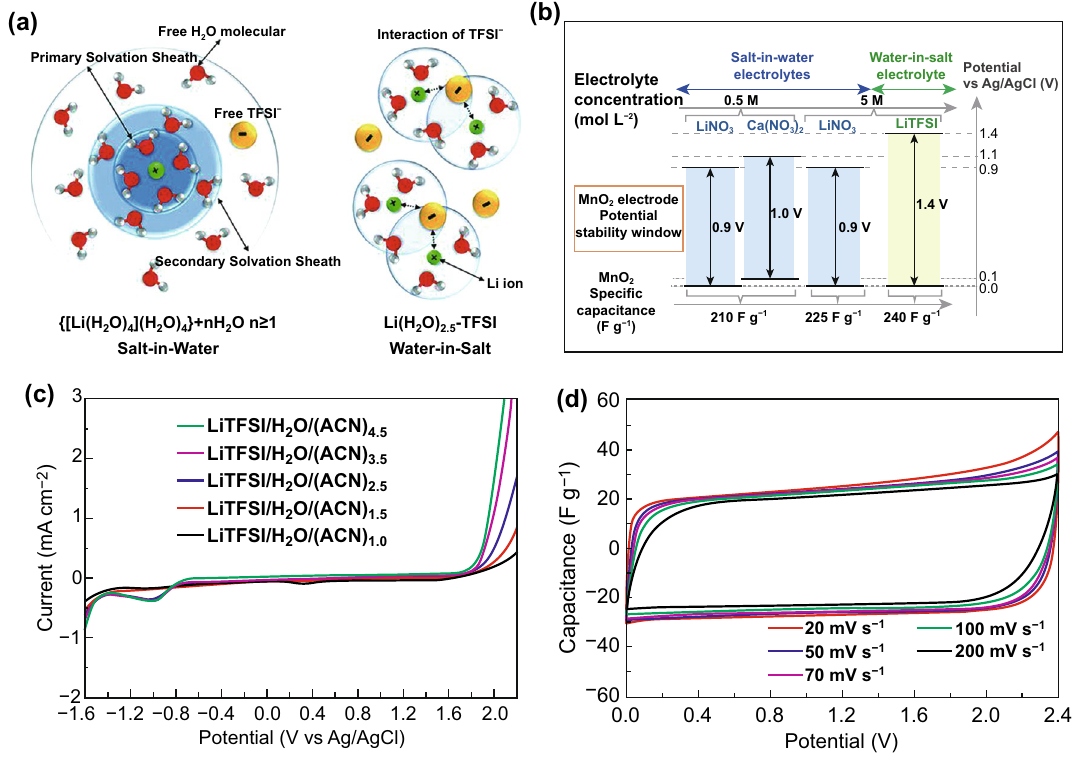
Fig. 8 a Illustration of the evolution of the Li + primary solvation sheath in diluted and water‑in‑salt solutions. Adapted with permission from Ref. [91]. b Potential range of MnO 2 composite electrode in WIS and SIW electrolytes. Adapted with permission from Ref. [95]. c ESWs of LiTFSI/H 2 O/(ACN) x hybrid electrolytes. d CV curves of the SC device using YP ‐ 50F electrodes and LiTFSI/H 2 O/(ACN) 3.5 electrolyte at differ‑ ent scan rates. Adapted with permission from Ref.